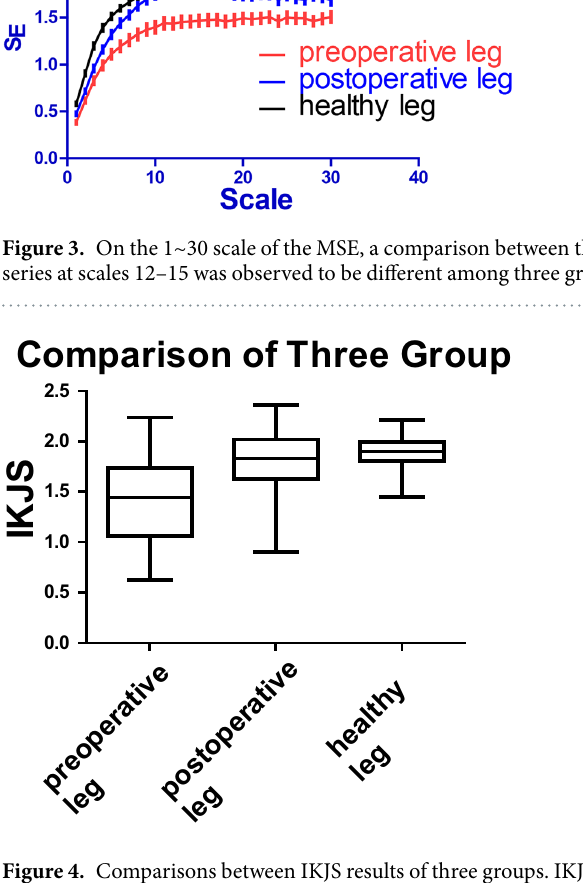
Figure 4. Comparisons between IKJS results of three groups. IKJS of healthy volunteers is better than patient, and postoperative patient comes closer to the healthy